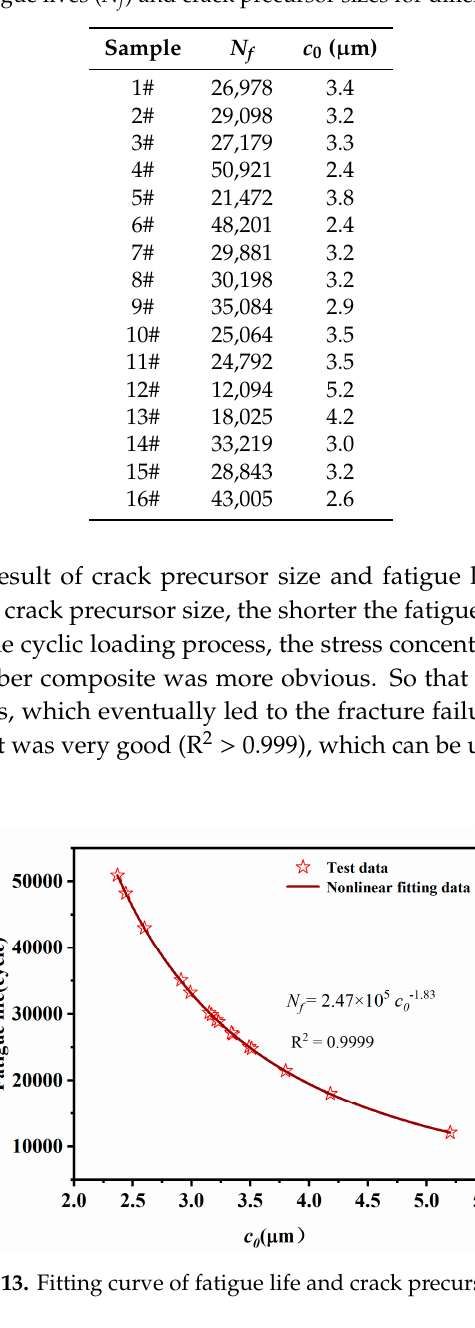
Table 4. Fatigue lives ( N f ) and crack precursor sizes for di ff erent samples.